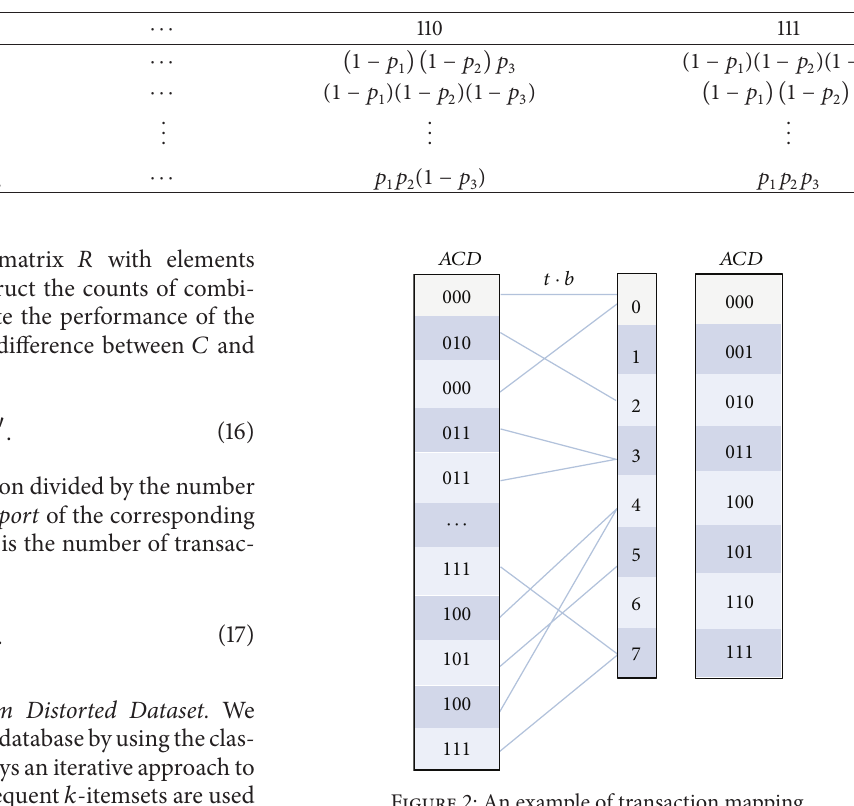
Table 1: An example of transition matrix.